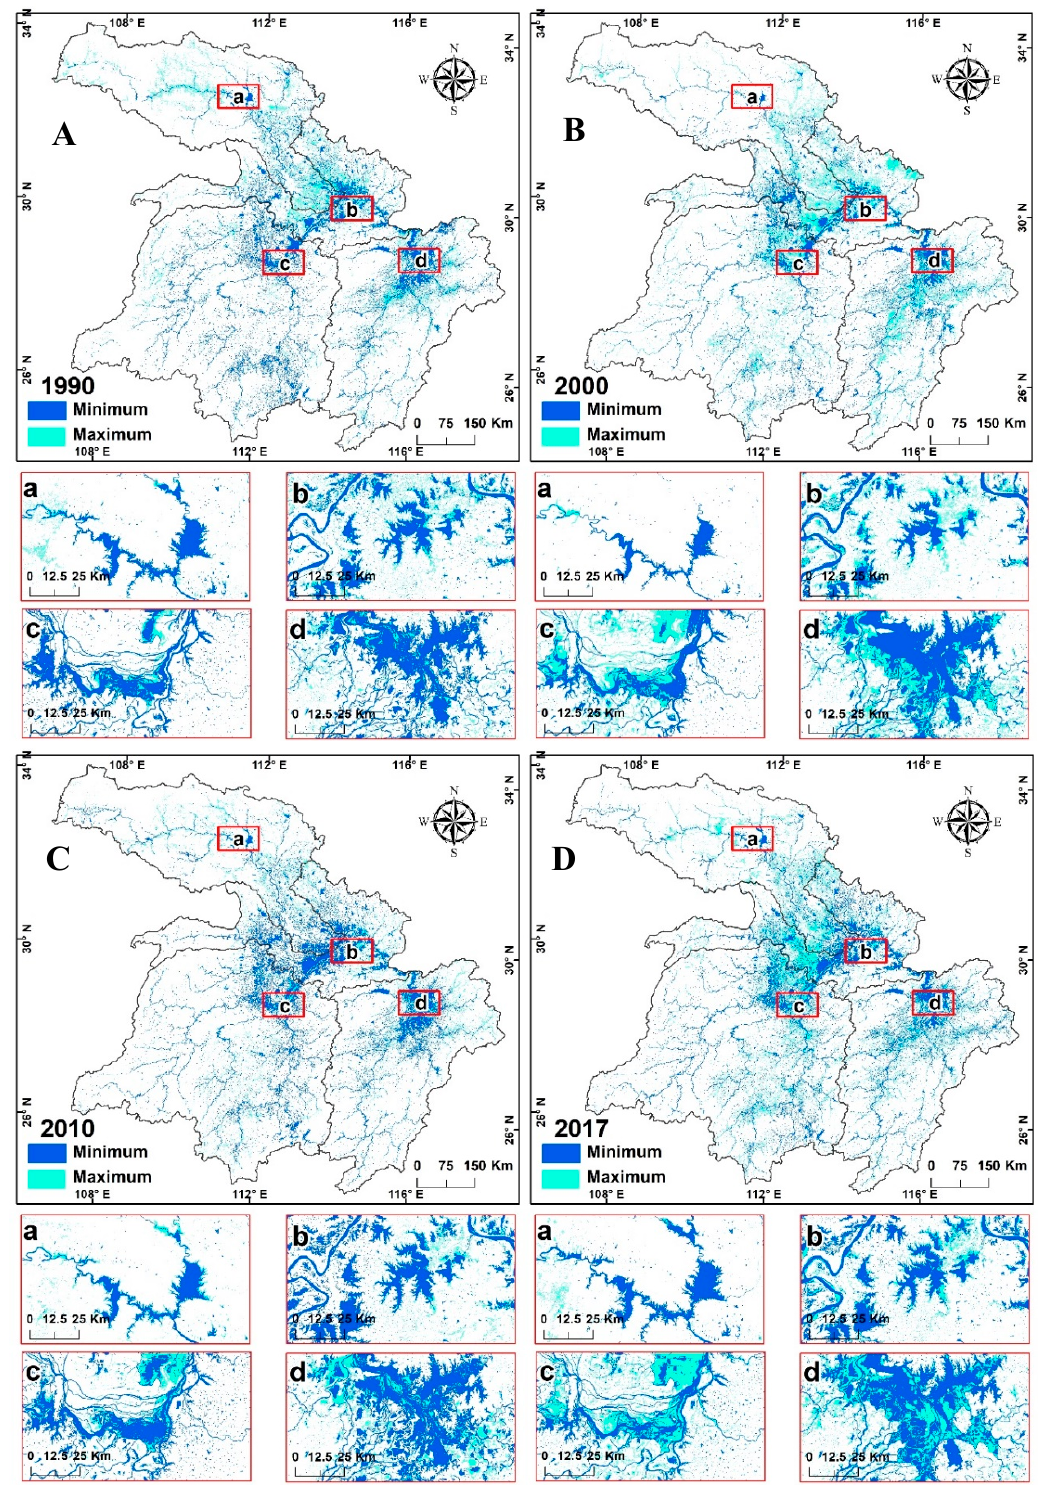
Figure 8. Yearly minimal and maximal surface water extent in 1990 (A), 2000 (B), 2010 (C), and 2017 (D).